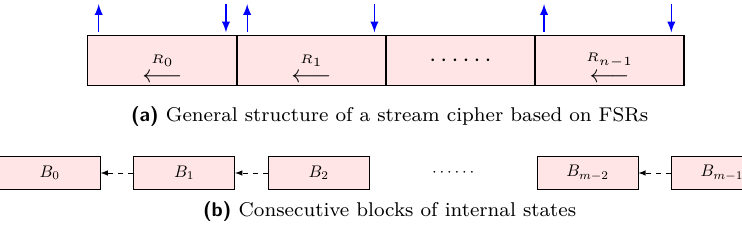
Figure 3: Internal state and its block